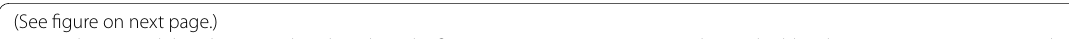
μm(See figure on next Fig. 4 rhFGF21 inhibited DOCA‑salt‑induced renal inflammatory response in mice. Eight‑week‑old male FGF21 WT mice were randomly divided into three experimental groups: the WT‑Control group treated with sham operation, followed by intraperitoneal injection with 0.9% normal saline; the WT‑DOCA group treated with DOCA‑salt; the WT‑DOCA‑FGF21 group treated with DOCA‑salt, followed by intraperitoneal supplementation of recombinant human FGF21 (rhFGF21, 500 μg/kg/day body weight). Kidney tissues were harvested at 8d after intervention. a Representative images of kidney sections stained with anti‑F4‑80 antibody, anti‑IL‑6 antibody and anti‑TNF‑α antibody, respectively, harvested from mice at 8 days after receiving DOCA‑salt treatment. The arrow indicates F4/80 positive cells. b and c Quantifications of IL‑6 and TNF‑α protein expression in the kidney tissues of each group were determined by using the mean integrated optical density (IOD)/area with Image‑Pro plus 6.0 image analysis software. d and e Kidney mRNA expression levels of IL‑6 and TNF‑α were determined by Q‑PCR and values normalized to GAPDH. Data are presented as Mean SD, n 6 mice/group. *P < 0.05, **P < 0.01 versus the WT control group; # P < 0.05, ## P < 0.01 versus the WT‑DOCA group. Scale bar: 100 ± =